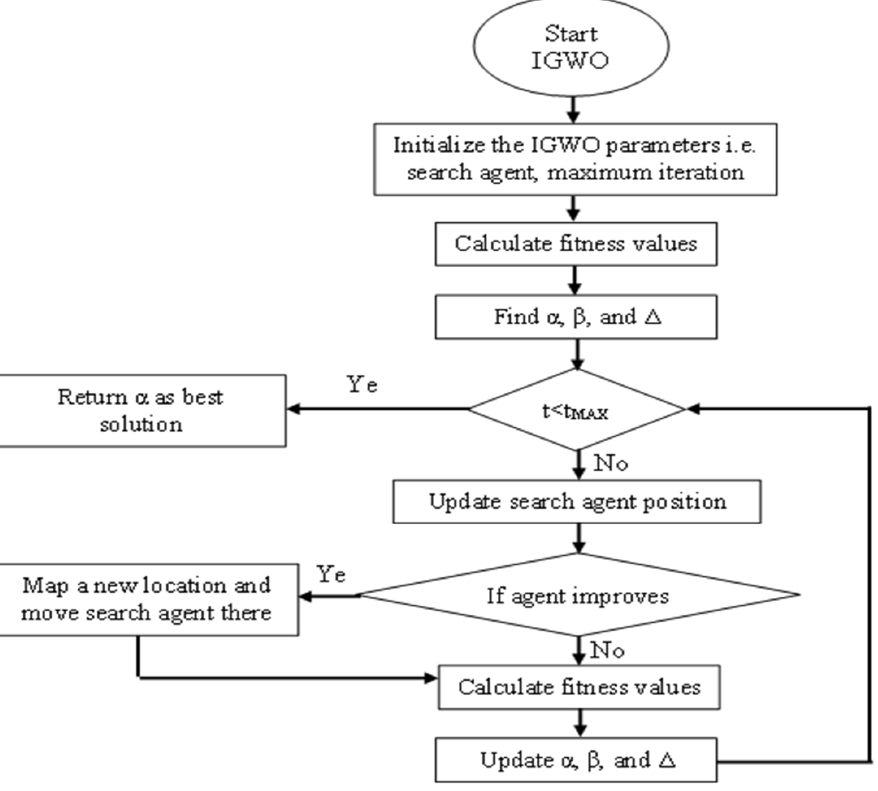
Figure 3. Flow chart of the IGWO approach process.